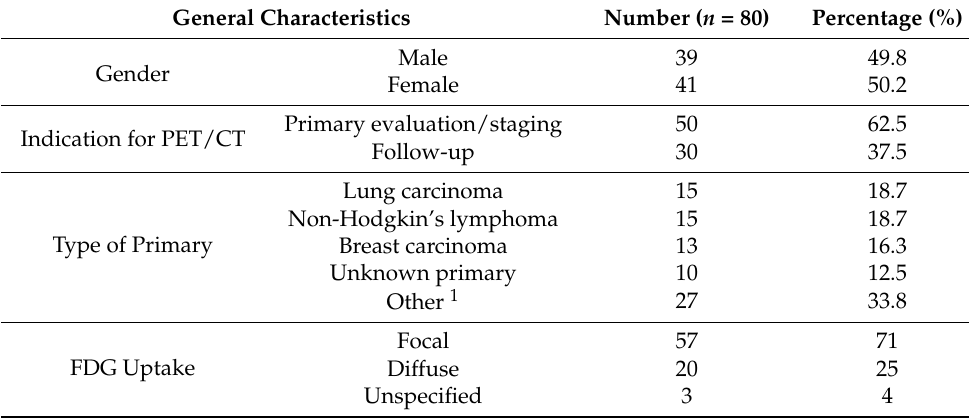
Table 2. General characteristics of the endoscopically followed-up